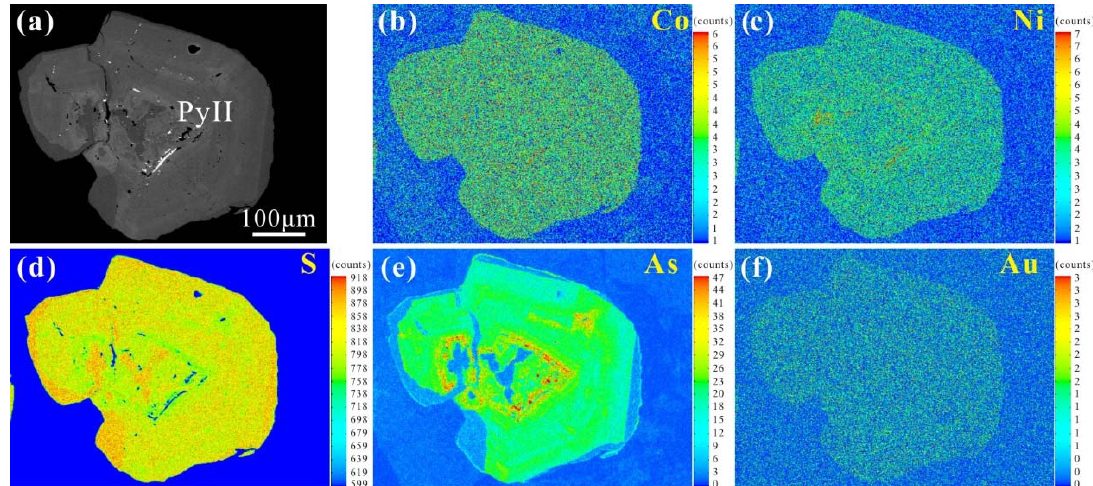
Figure 8. ( a ) Backscattered electron image of PyII from sample 290-8. ( b – f ) X-ray element distribution maps of Co, Ni, S, As, and Au in PyII. PyII contains weakly visible growth zoning indicating that cobalt, nickel and arsenic are present in similar concentric zones in these crystals.